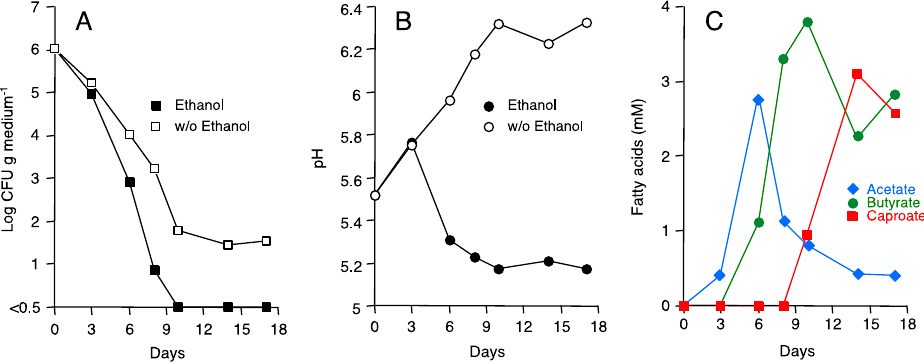
Figure 1. Viable number of Fusarium oxysporum f. sp. lycopersici conidia ( A ), cocopeat medium pH ( B ), and volatile fatty acid production ( C ) during laboratory-scale anaerobic soil disinfestation (ASD).